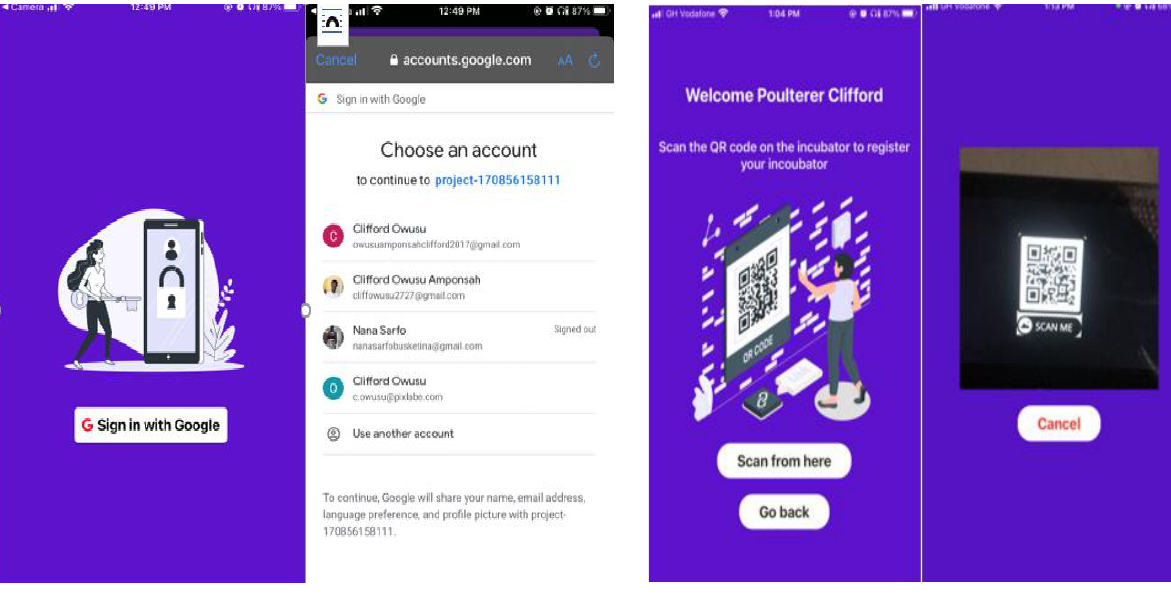
Figure18. Sign in page with Google Oauth Figure 19. Add incubator screens